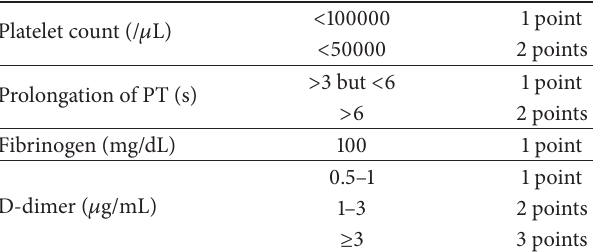
Table 1: International Society of Thrombosis and Hemostasis (ISTH) criteria for overt versus nonovert DIC. A score greater than or equal to 5 is compatible with overt DIC whereas a score less than 5 is suggestive for nonovert